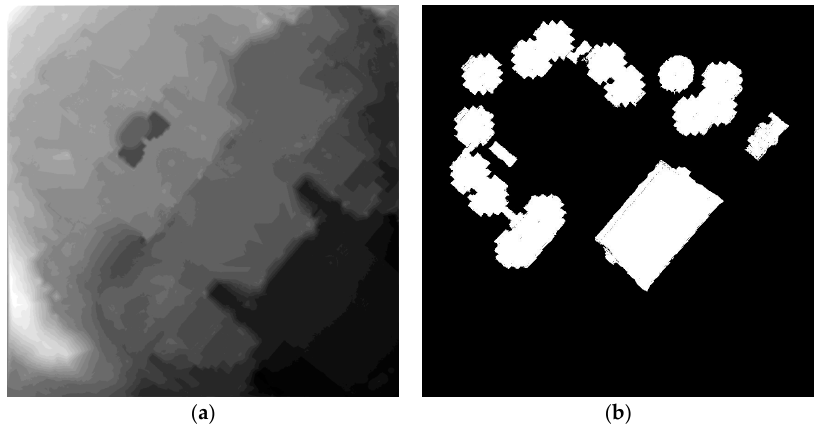
Figure 3. Building information extracted from airborne LiDAR: ( a ) DTM; ( b ) building information (white areas). (white